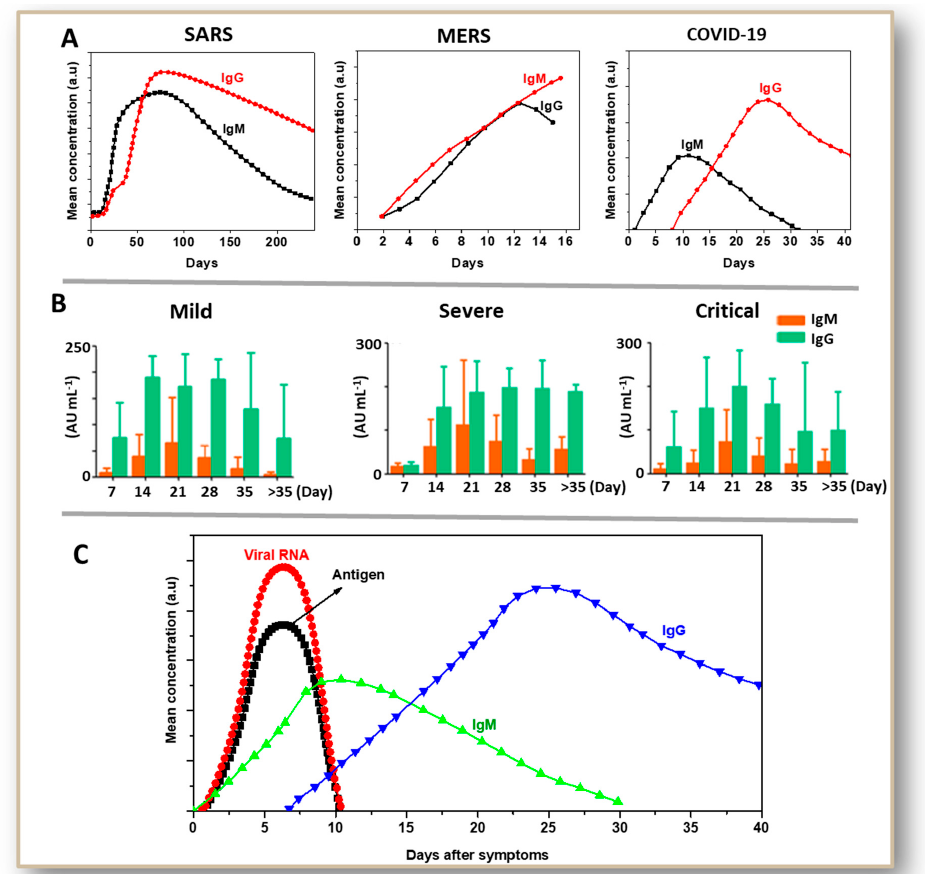
Figure 3. Immunoglobulin M (IgM) and Immunoglobulin G (IgG) serology profiles of SARS,